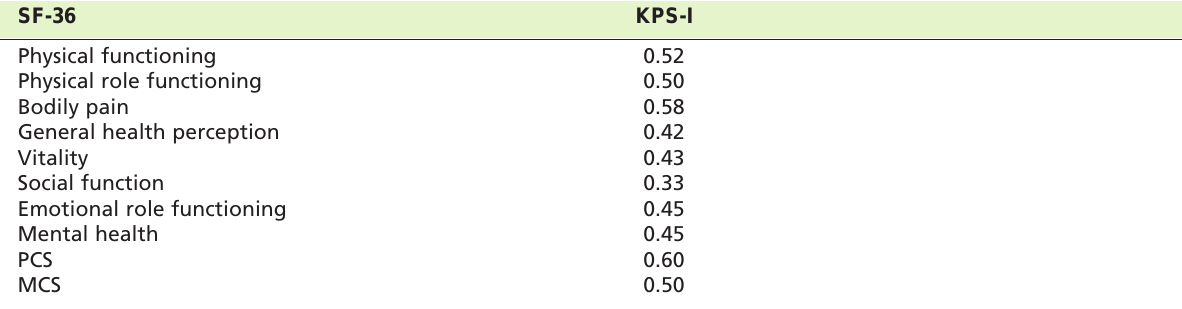
Correlations Between KPS-I and the Domains of the Table IV: